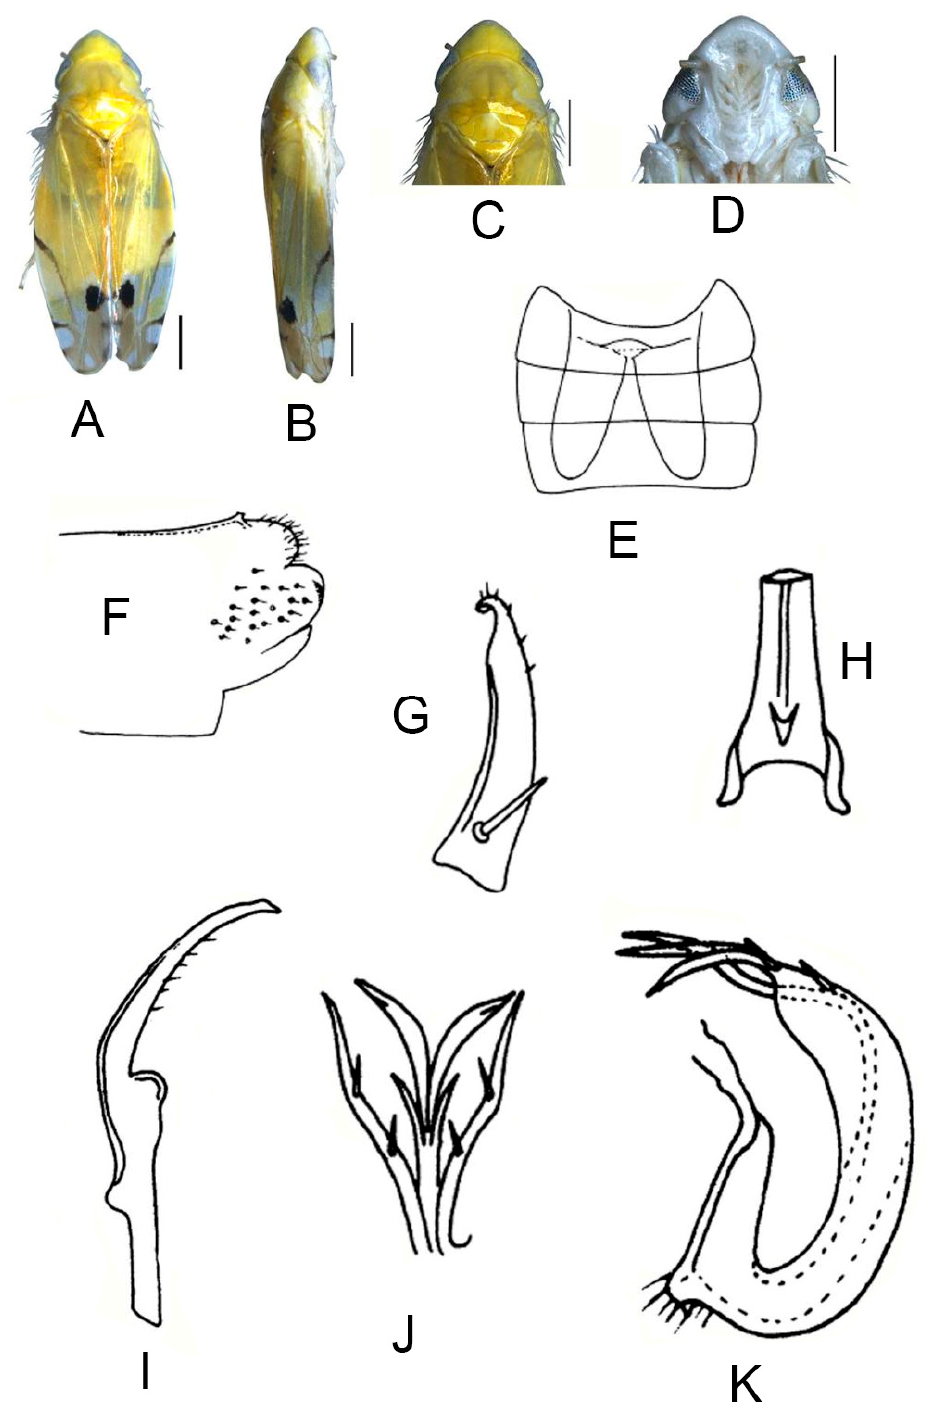
Figure 13. Eurhadina ( Singhardina ) diplopunctata ( E – K : Huang et Zhang, 1999 [8]): ( A ) habitus, dorsal view; ( B ) habitus, lateral view; ( C ) head and thorax, dorsal view; ( D ) face; ( E ) abdominal apodemes, dorsal view; ( F ) male pygofer side, lateral view; ( G ) subgenital plate, dorsal view; ( H ) connective, dorsal view; ( I ) paramere, dorsal view; ( J ) apex of aedeagal shaft, dorsal view; and ( K ) aedeagus, lateral view. Scale bars: 0.5 mm.